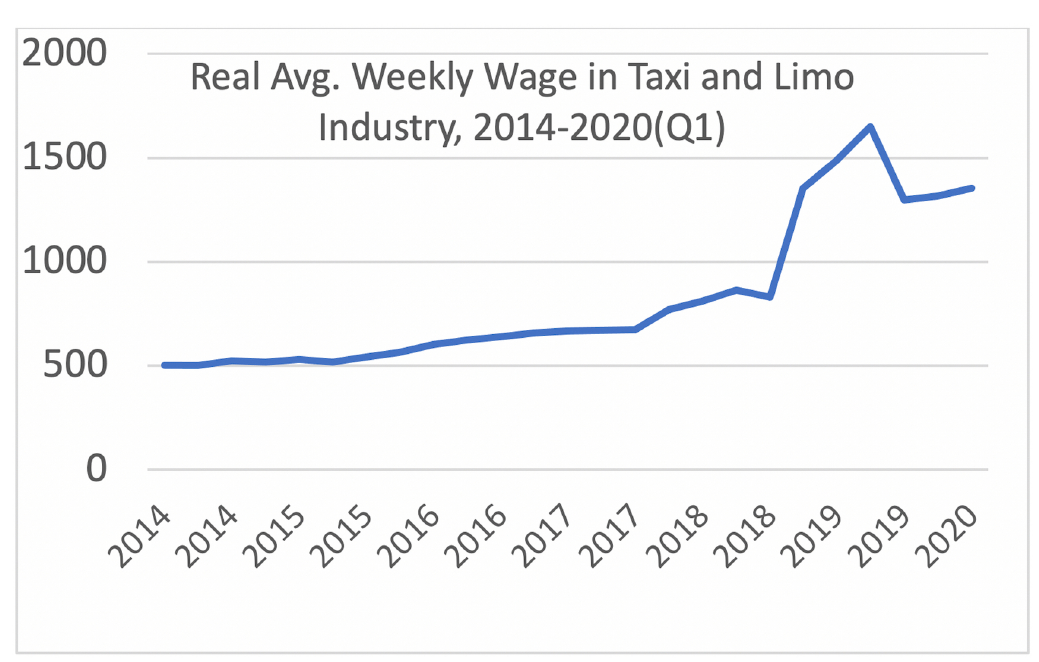
Figure 7: Trend in real average weekly wage among employees in the taxi and limousine industry, 2014–2020. Data from Quarterly Census of Employment and Wages, 2015–2020. Tripling of wages suggests influx of high-salaried technology jobs, a potential signal of a pre-automated strategy in